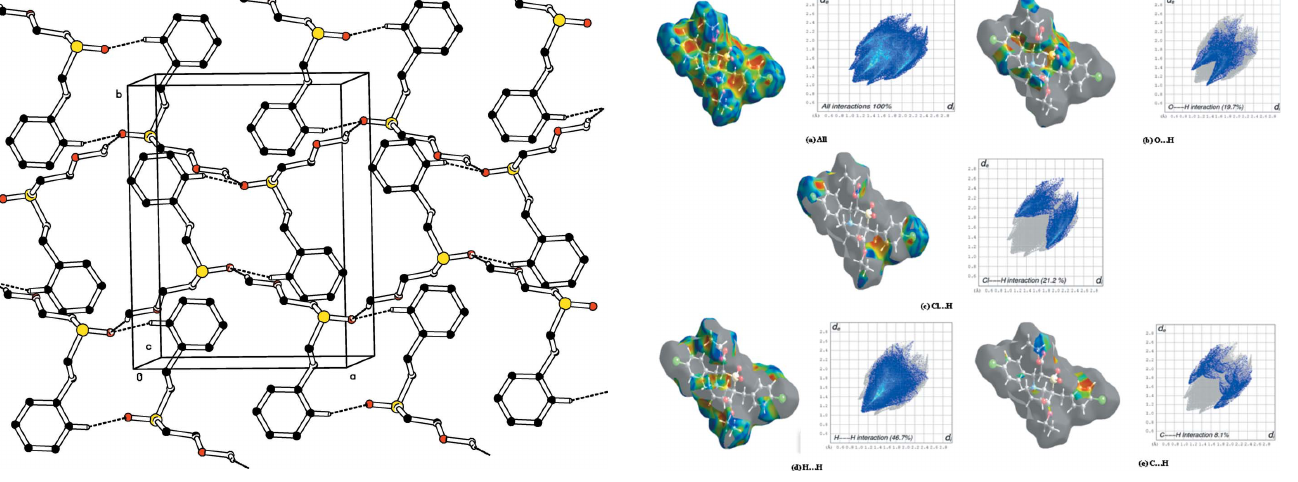
Figure 3 Part of the crystal structure of compound (I), showing the formation of an R 2 (14) ring. Dashed lines indicate hydrogen bonds. H atoms not involved 2 in the hydrogen bonding have been omitted for the sake of clarity.